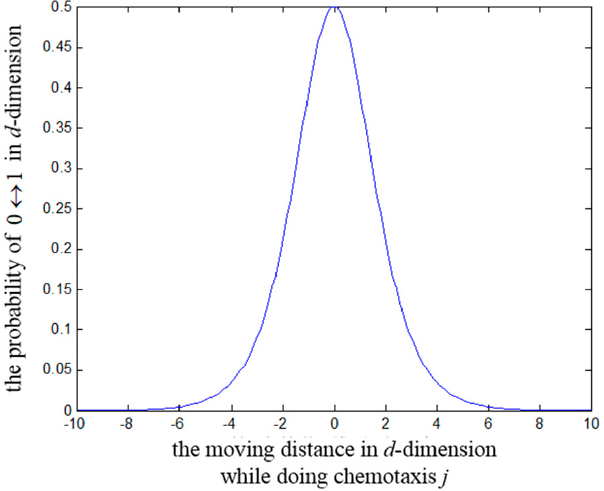
Figure 9. Two chemotactic distances and changing probability of 0 ↔ 1.